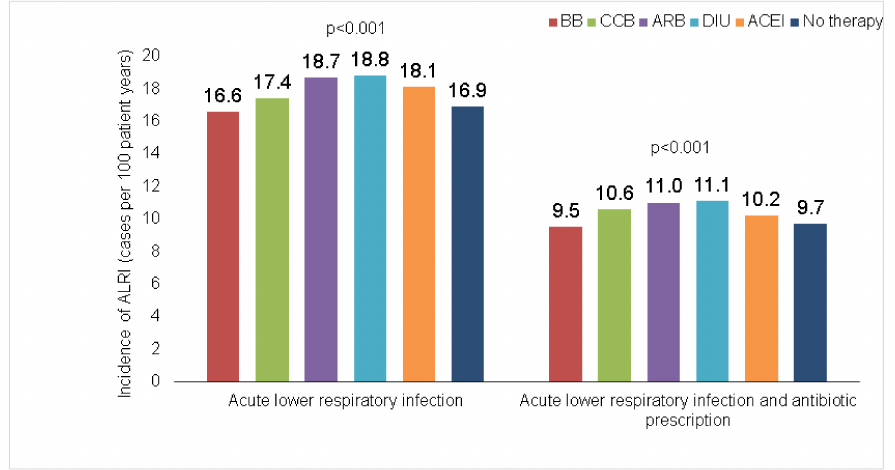
Figure 2. Proportion of individuals with a diagnosis of lower respiratory infection and antibiotic therapy within 12 months in patients treated with different antihypertensive drugs.